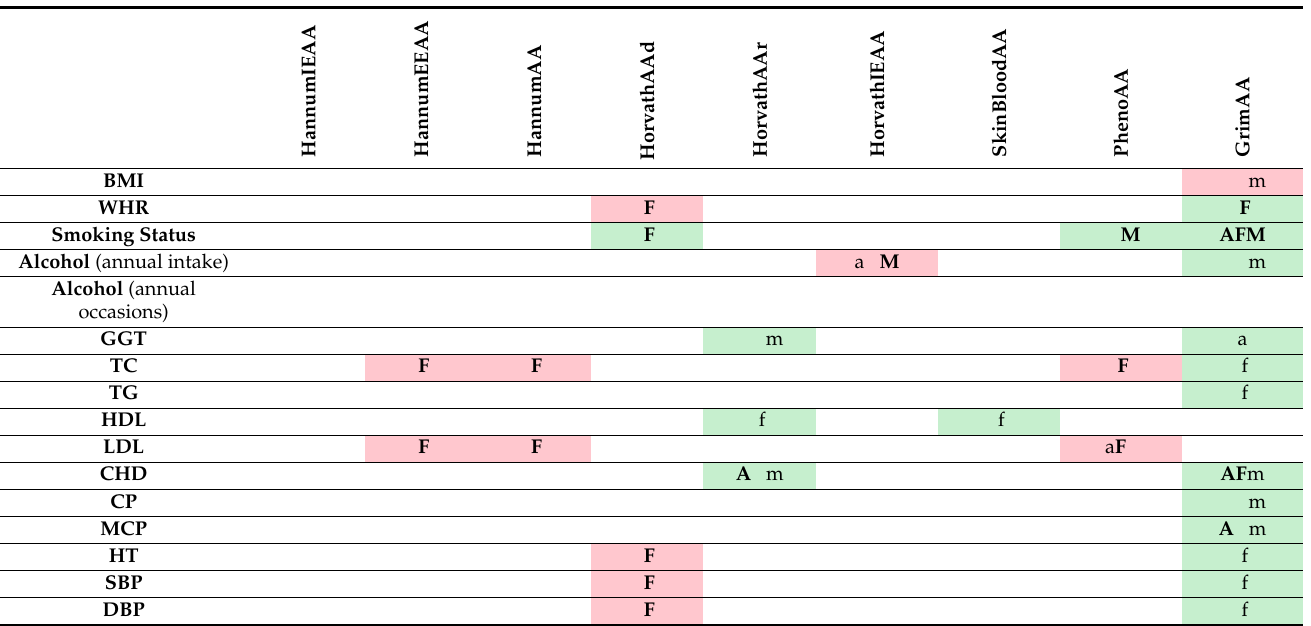
Table 3. EAA–phenotype association table. White colour indicates no significant association, green/red colour indicate significantly higher/lower values of phenotype measures (higher odds ratios) in EAA + group compared to EAA − for continuous (binary) phenotypes. Lower case letters indicate individual significant associations between a clock and a phenotype for all cohort partici- pants (a), females (f), and males (m); capital letters indicate phenotype group significant association (controlled for family-wise error rate) for all ( A ), females ( F ), and males ( M ).